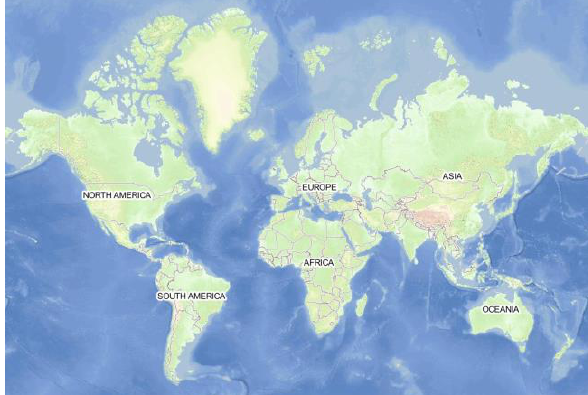
Figure7. Effect with ultimate values of three factors on website